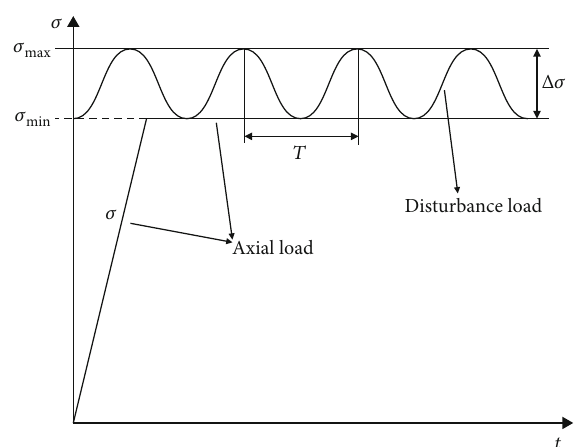
Figure 2: Schematic diagram of disturbance